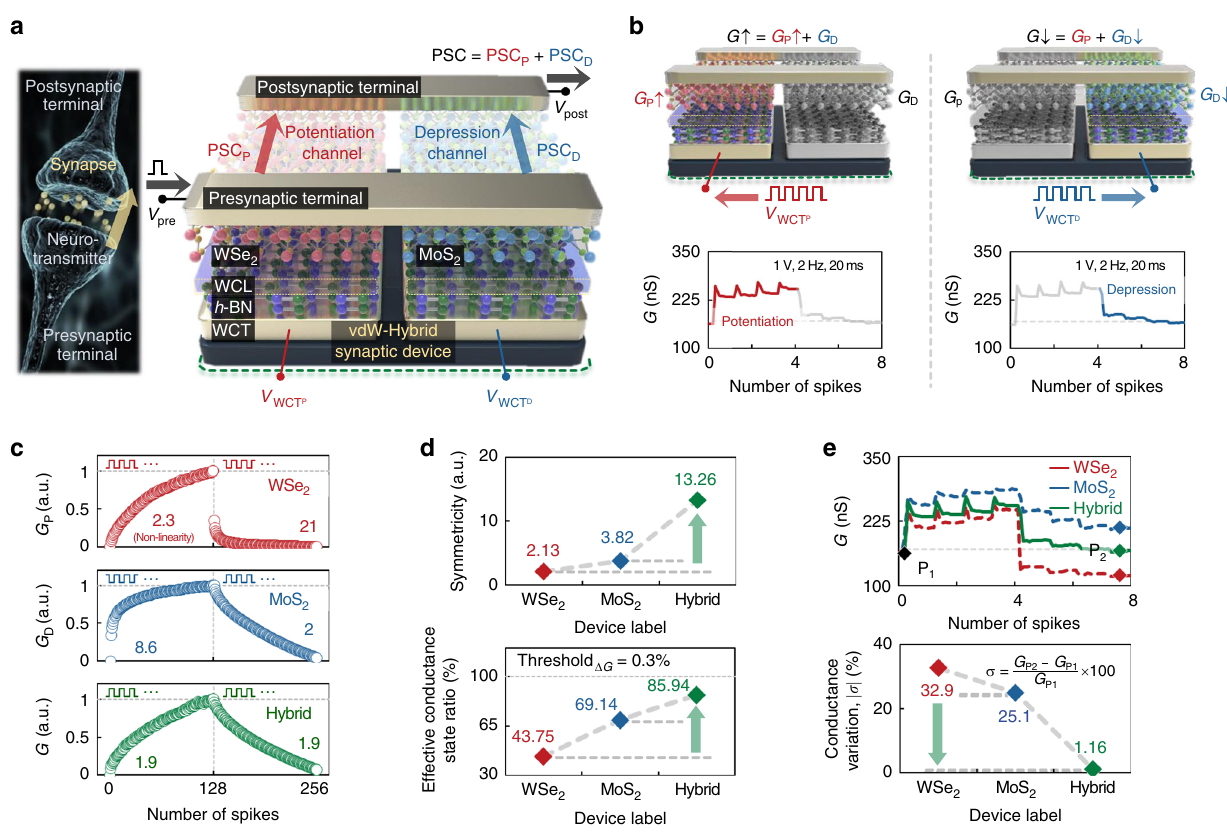
Fig. 1 vdW-hybrid synaptic device with excellent controllability of the conductance. a Functional and structural comparison of the biological synapse with the vdW-hybrid synaptic device. b Demonstration of potentiation and depression operations with four spikes. c Long-term potentiation (LTP) and depression (LTD) curves including extracted nonlinearity values for the control devices (WSe 2 and MoS 2 synaptic devices) and the vdW-hybrid synaptic device, where 128 excitatory and inhibitory spikes were applied consecutively to the WCTs. d Symmetricity and effective conductance-state ratio (threshold Δ G = 0.3%) extracted from the LTP/LTD curves. e Conductance responses when eight spikes were applied in a row (four excitatory and four inhibitory) to the WCTs of the three types of devices, and extracted conductance variations | σ